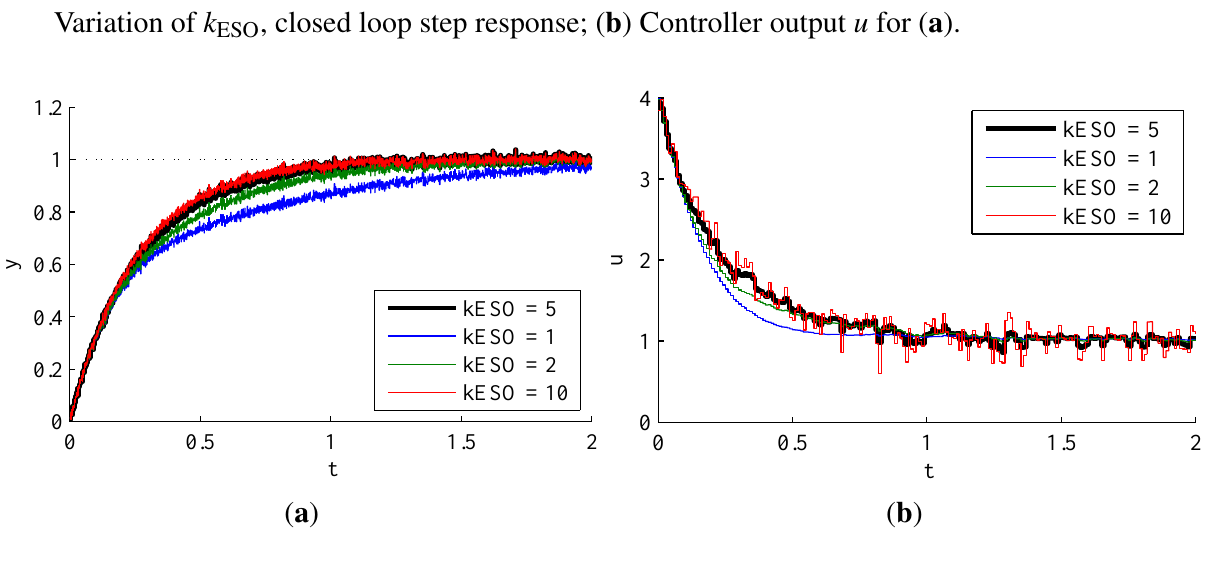
on discrete-time ESO = 0 . 0001. ( a ) noise